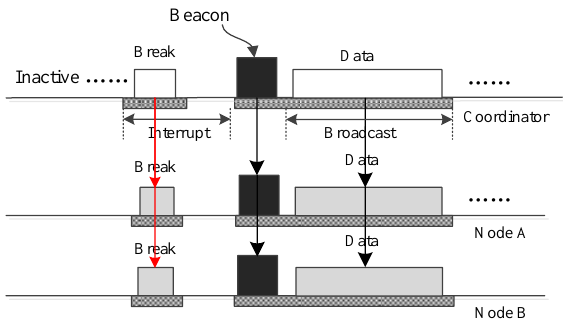
Figure 9. The coordinator broadcasts big data to all